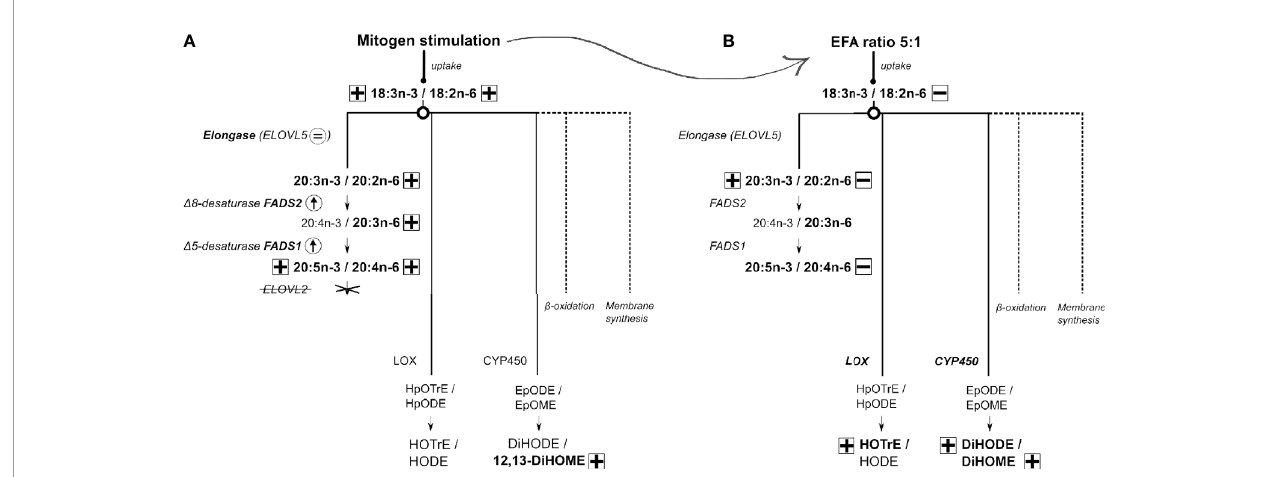
FIGURE 8 | A model for 18:3n-3 and 18:2n-6 metabolism in human CD3 + T lymphocytes and the effect of response to stimulation and different ratios of 18:3n-3 and 18:2n-6 substrates. Arrow or an equal sign within a circle indicates either an increase or no change in mRNA expression. Plus or minus in a square indicates either an increase or decrease in polyunsaturated fatty acid (PUFA)/oxylipin concentration, respectively. Dotted lines refer to possible other mechanisms not further explored in this work. (A) The metabolic fates of 18:3n-3 and 18:2n-6 in stimulated compared to unstimulated T cells. (B) The metabolic fates of 18:3n-3 and 18:2n- 6 in stimulated cells cultured in medium with a 18:2n-6:18:3n-3 ratio of 8:1 compared to cells maintained in medium with a 18:2n-6:18:3n-3 ratio of 5:1. A detailed description is presented in the Discussion